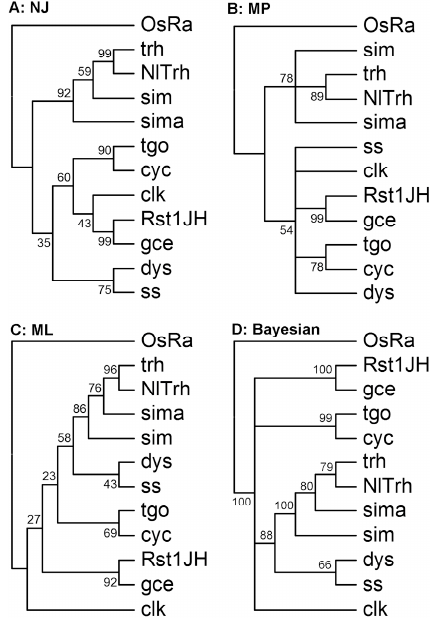
Figure 3. Ingroup phylogenetic analyses of NlTrh . ( A – D ) are NJ, MP, ML and Bayesian trees, respectively, constructed with one N. lugens bHLH member ( NlTrh ) and ten group C bHLH members from D. melanogaster . In all the trees, OsRa was used as outgroup. Table 3. Comparisons of bHLH family members from twelve insect